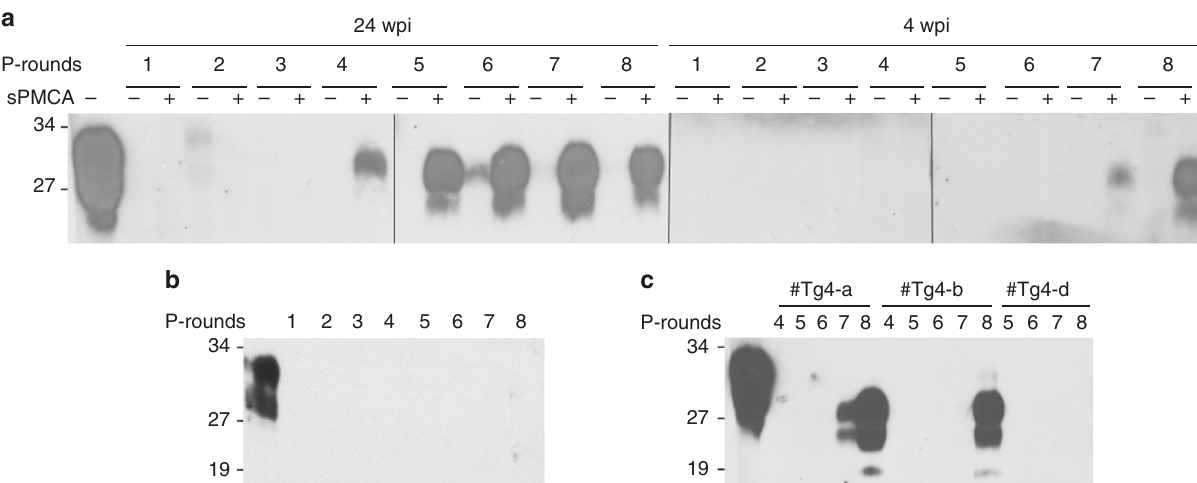
Fig. 4 Detection of skin PrP Sc by sPMCA in the Tg40h mice. a Representative western blotting of PrP Sc ampli fi ed by eight rounds of sPMCA with belly skin homogenate from humanized Tg40h mice inoculated with sCJDMM1 homogenate and killed at 28 wpi or 4 wpi. b Representative western blotting of the belly skin samples from PBS-inoculated Tg40h mice after 8 rounds of sPMCA from three-independent experiments. c Representative western blot analysis of ampli fi ed PrP Sc from the thigh skin of prion-infected Tg40h mice killed at 4 wpi (#Tg4-a or #Tg4-b) by 4 – 8 rounds of sPMCA from three-independent experiments. #Tg4-d was the PBS-inoculated Tg40h mouse control in cohabitation with sCJDMM1-inoculated mice. P-rounds: number of sPMCA rounds. All samples were treated with PK at 100 µ g/ml except for the sample in the fi rst lane of the blots that was used as a non-PK treatment control. The blots were probed with 3F4. The molecular weight markers are shown in kDa on the left side of the